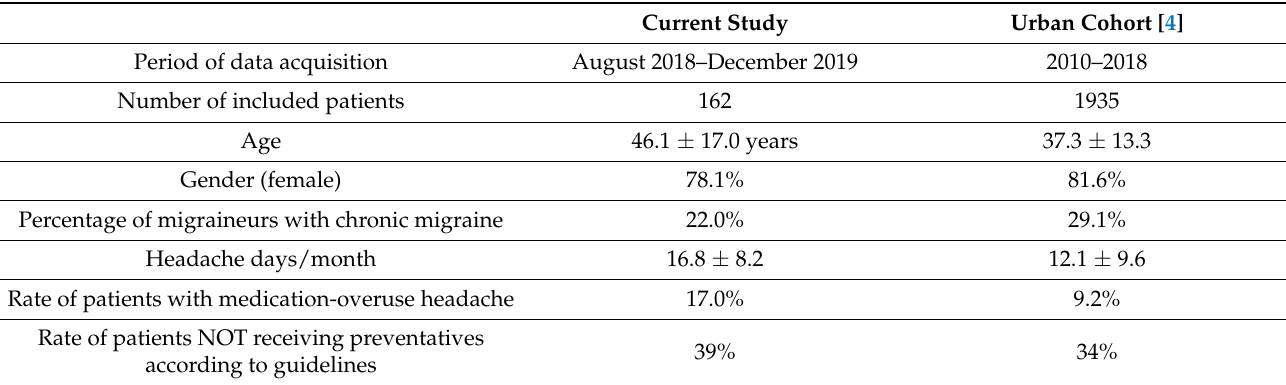
Table 3. Overview of the population characteristics investigated in the current study and its comparison to a population in an urban area. It can be seen that patients in the rural area tended to be older, more severely affected in terms of medication overuse and headache days and less likely to receive guideline adherent prophylactic treatment. In apparent contradistinction, the rate of chronic migraineurs seems to be lower. This is resolved by the fact that the current study also investigated other headache disorders, including chronic tension type